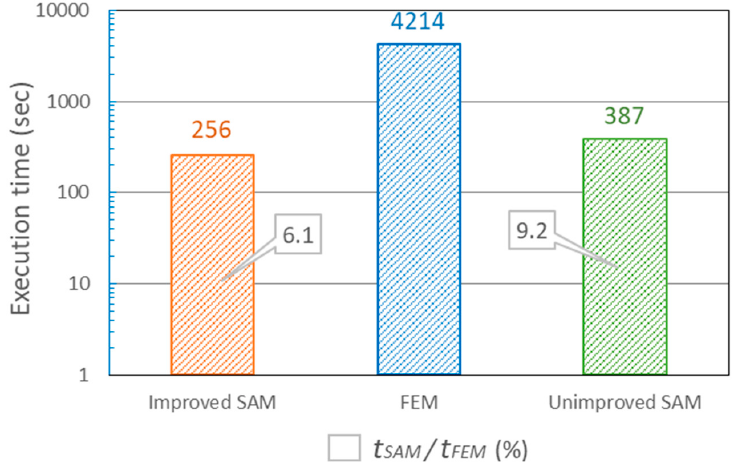
Figure 7. Comparison of the execution time of the improved semi-analytical method (SAM), finite element method (FEM), and unimproved SAM models.